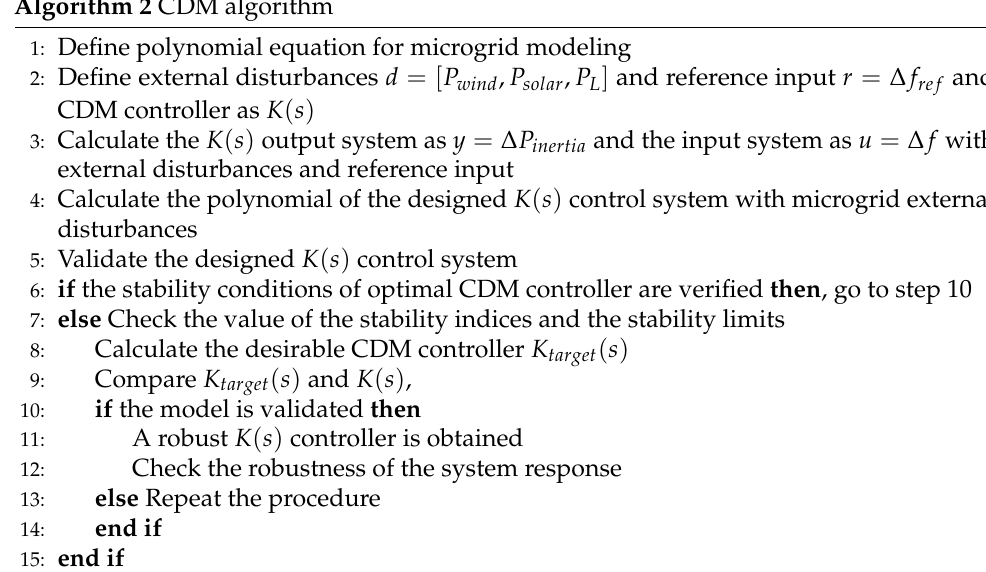
Algorithm 2 CDM